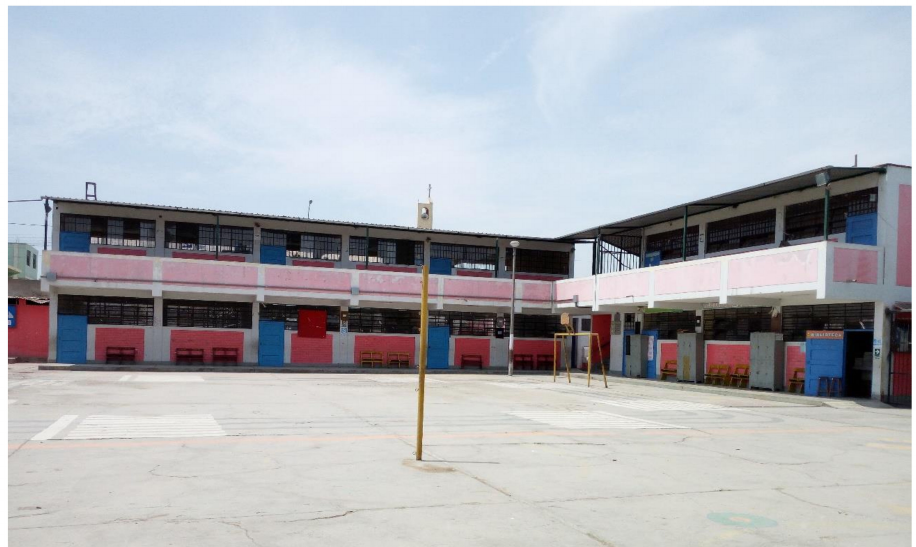
Figure 2. Characterization of existing buildings: PREbuilding type.